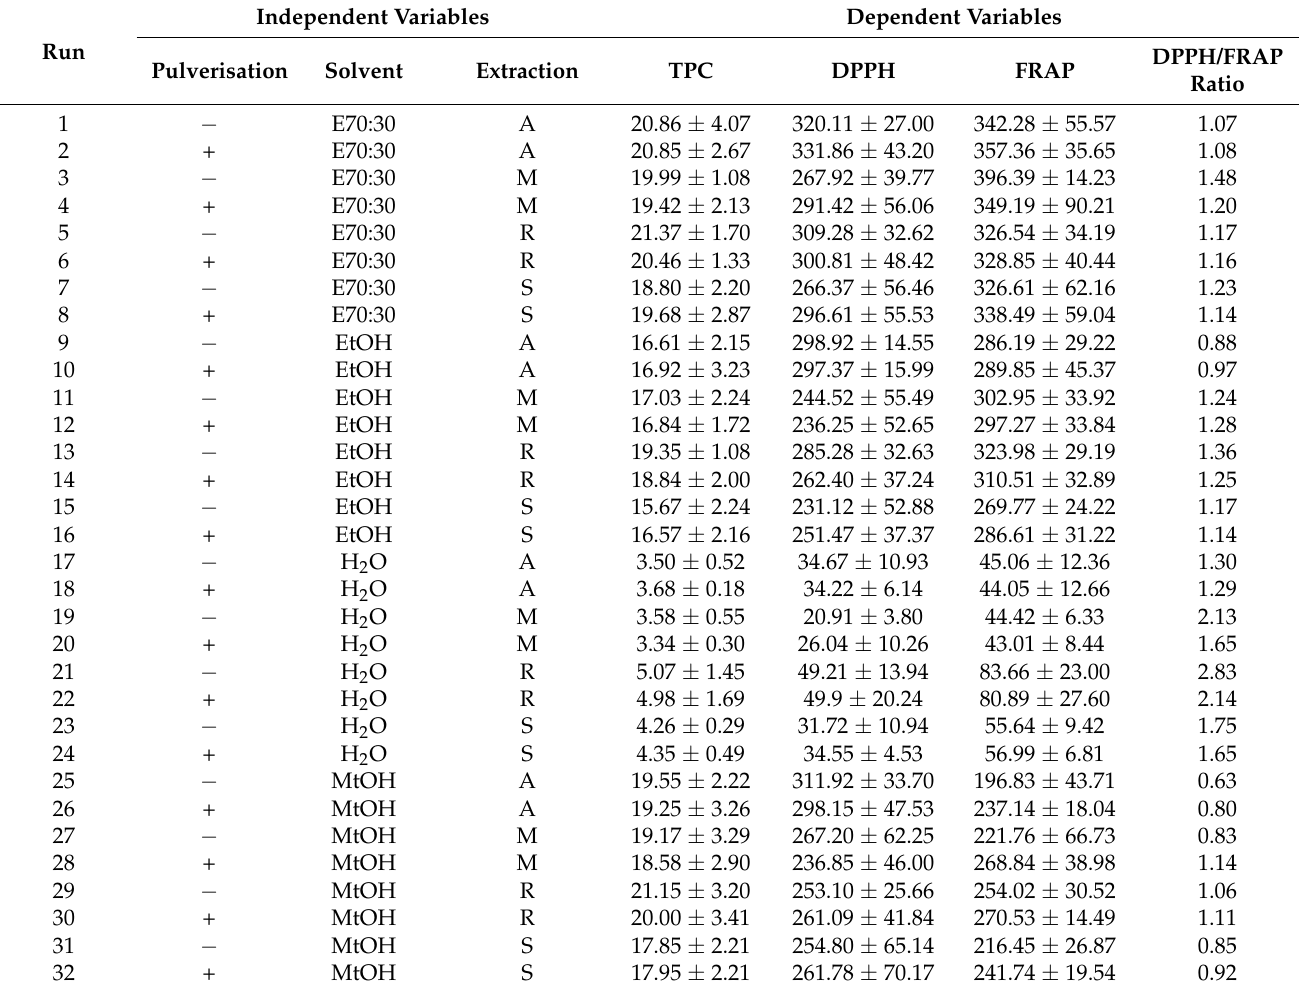
Table 3. Multilevel factorial experimental design to optimise the extraction of antioxidant components in bee pollen. Experiments were conducted with 3 independent variables and the responses comprised of antioxidant activity measured by the TPC, DPPH and FRAP